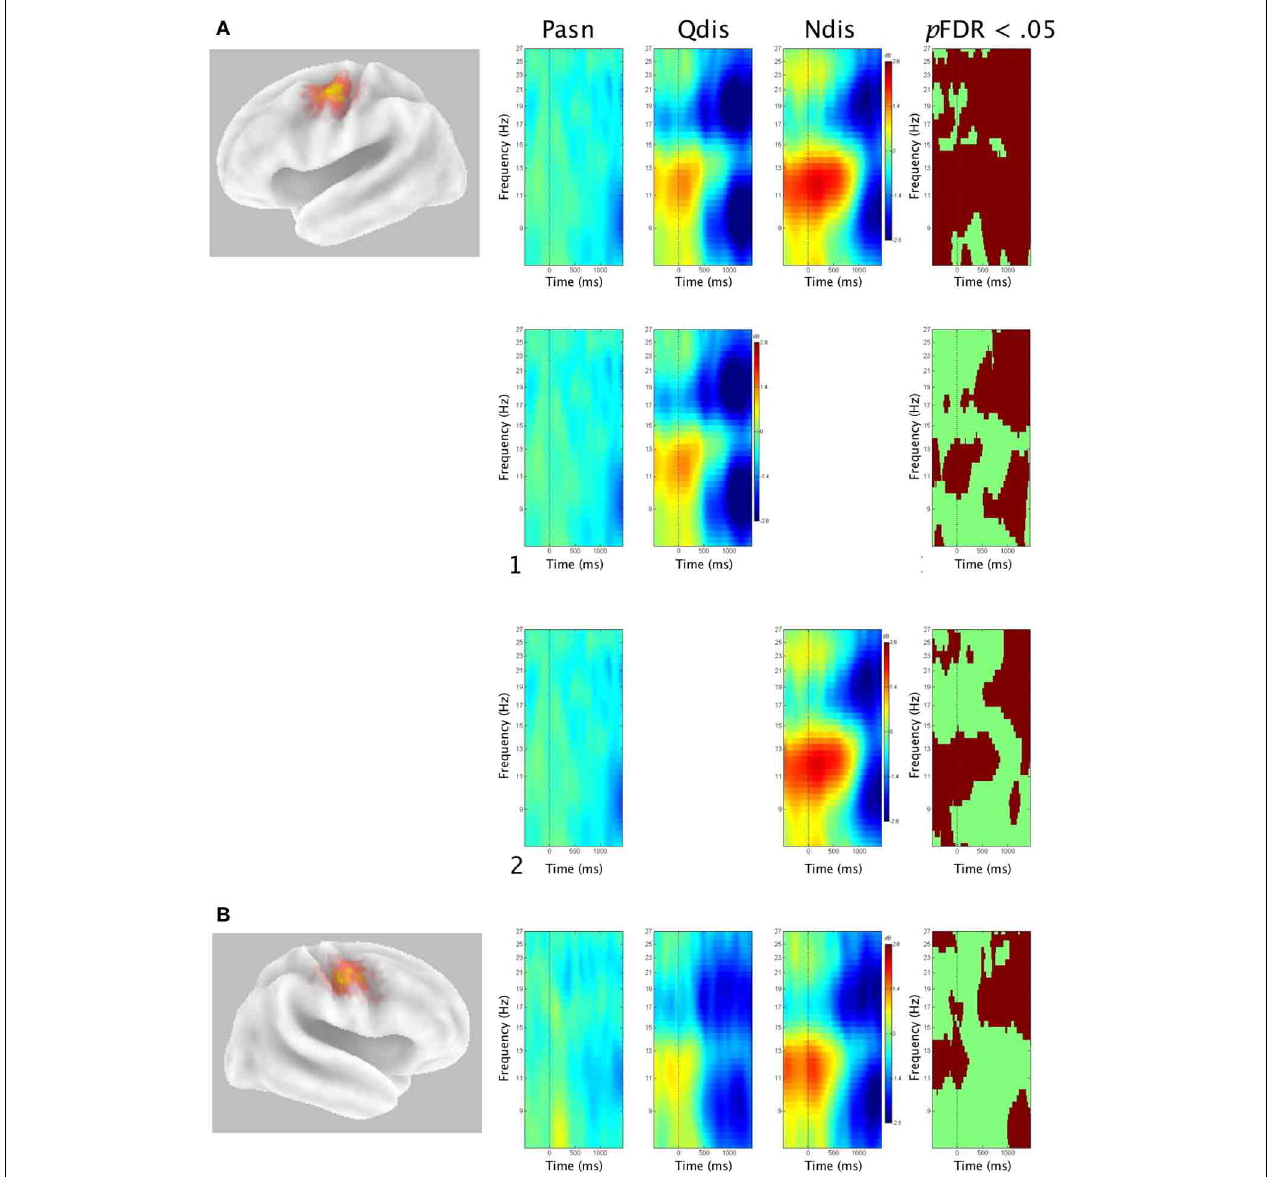
FIGURE 5 | Mean left and right ERSPs and sLORETA solutions for perception conditions. Rows A and B show sLORETA solutions for left and right µ clusters, respectively, depicted on a 3D Van Essen average template, followed by mean time-frequency ERSPs (event-related spectral perturbations) as a function of perception